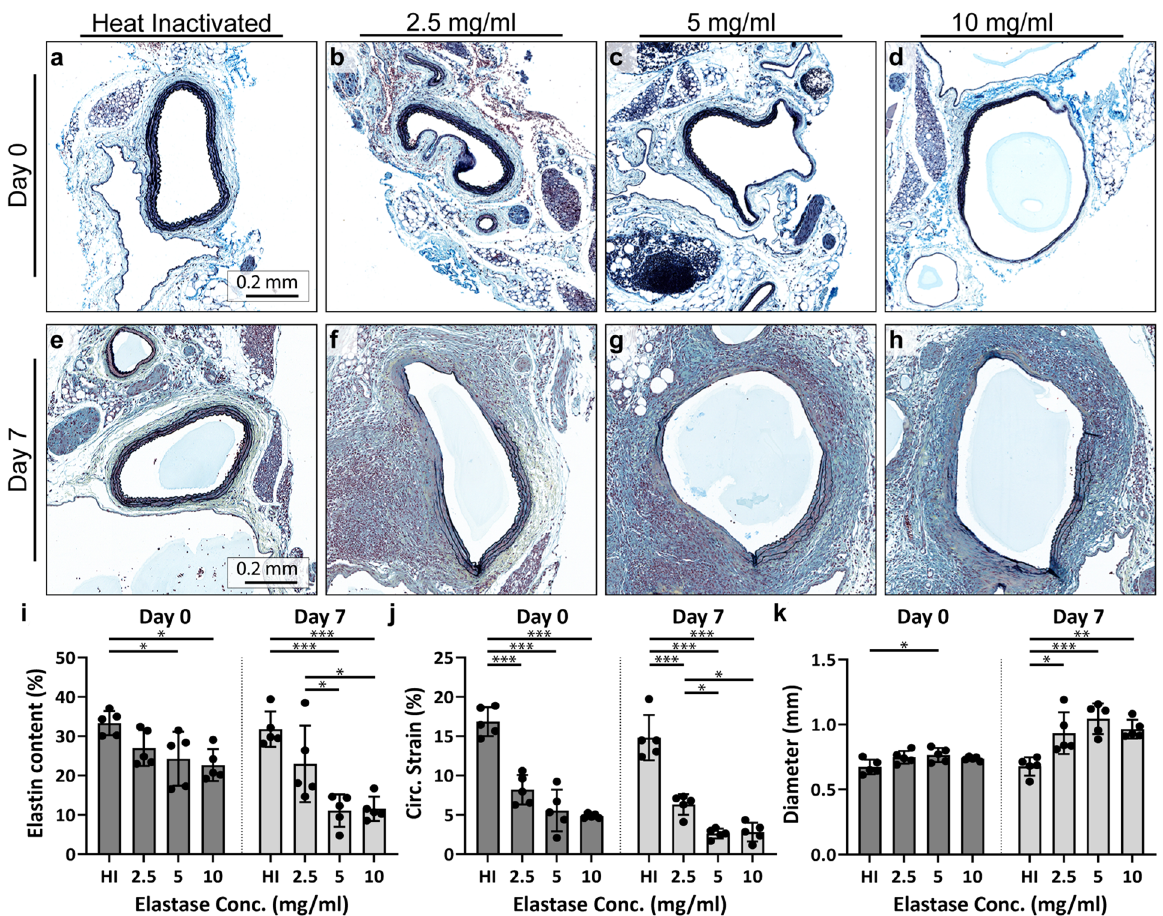
Figure 4. Short-term effects in mice treated with varied elastase concentrations. Terminal and acute MPC and ultrasound results of the topical elastase procedure revealed an immediate reduction in elastin integrity compared to the heat-inactivated group. ( a ) Heat-inactivated elastase-treated mice qualitatively showed no damage post-surgery compared to the ( b ) 2.5 mg/ml, ( c ) 5 mg/ml, and ( d ) 10 mg/ml groups. ( e ) By day 7, heat-inactivated elastase-treated mice similarly showed no damage, but the ( f ) 2.5 mg/ml, ( g ) 5 mg/ml, and ( h ) 10 mg/ml groups also showed diffuse damage. ( i ) Quantification of intact elastin showed similar results. In addition, ultrasound was used to quantify ( j ) strain and ( k ) diameter. * p < 0.05; ** p < 0.01; *** p <